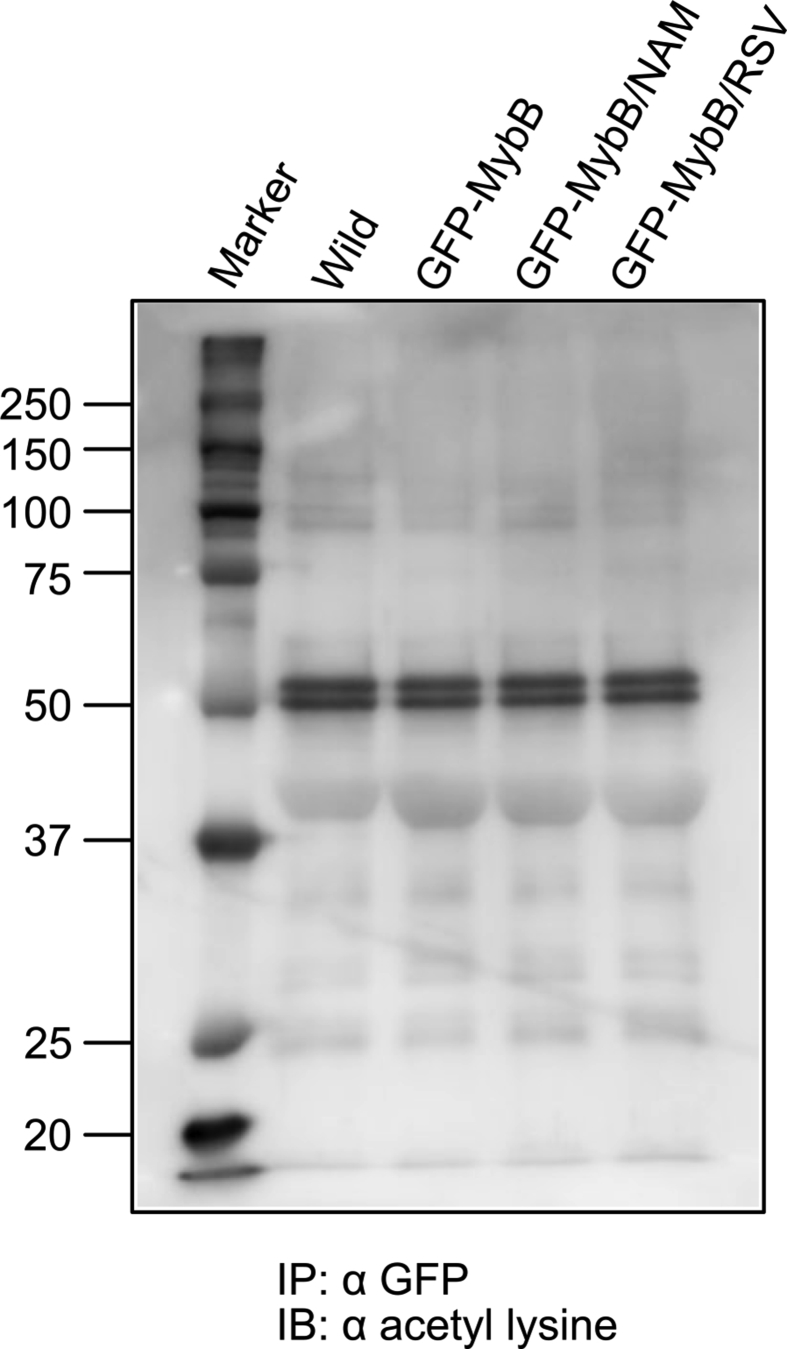
Supplementary Fig. S7.eps